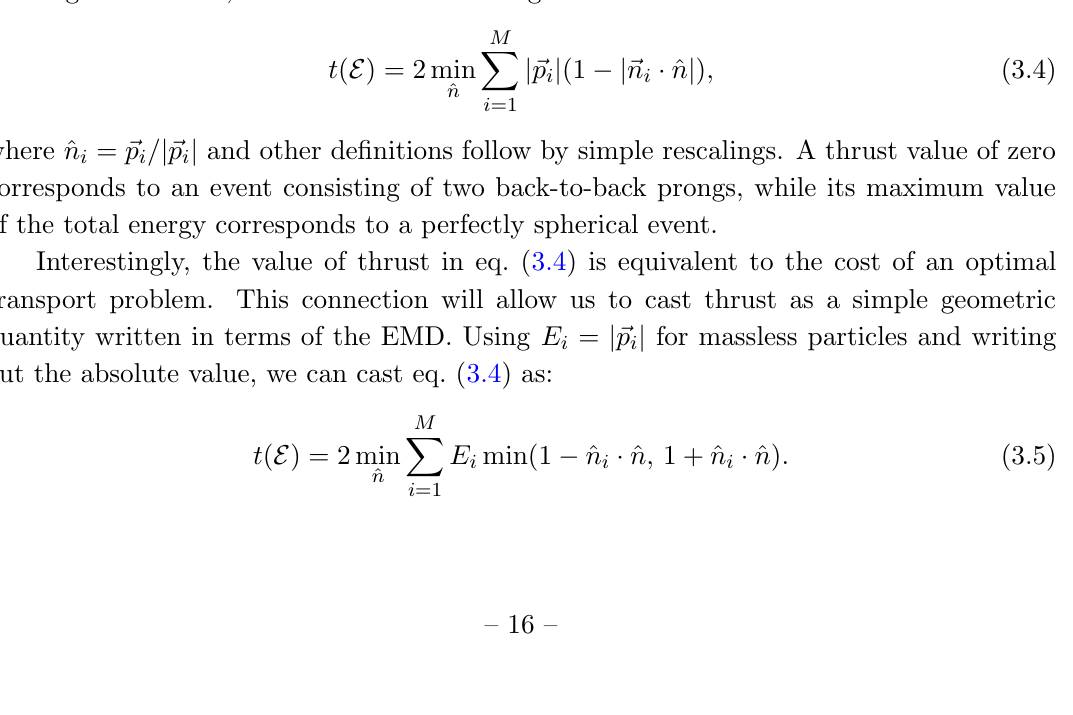
BB of two-particle back-to-back events, while event isotropy 2 P . (b) N -jettiness observables U P N